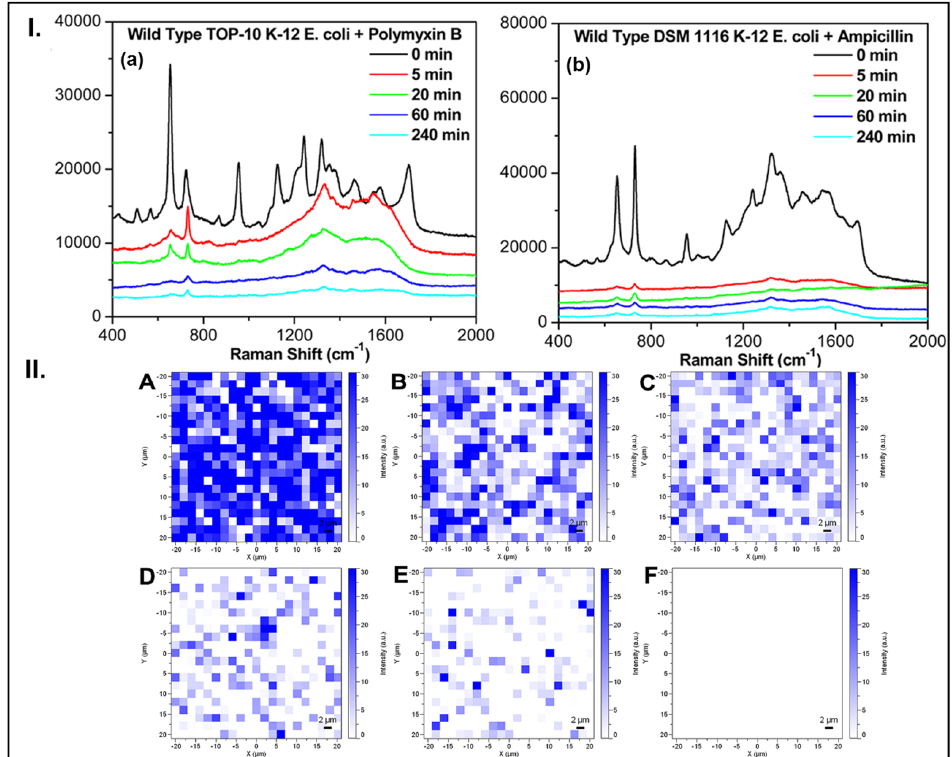
Figure 3. ( I ) In situ SERS spectral profiles of sensitive wild type E. coli K-12 TOP-10 and K-12 DSM. Strains ( n = 116) treated with ( a ) Polymyxin B and ( b ) Ampicillin, harvested at different time points. By visual inspection, the intensity of SERS bands decreased while new bands appeared with increasing time in both cases. ( II ) SERS images showing increasing concentrations of dead E. coli cells, A. 0%, B. 5%, C. 25%, D. 50%, E. 75% and F. 100%, quantified by 735 cm −1 band, clearly indicating that no SERS signals were detected on dead cells. Colour code: Blue = live cell and white = dead cell. Reprinted with permission from Zhou et al. [17]. Copyright © 2017, American Chemical Society.